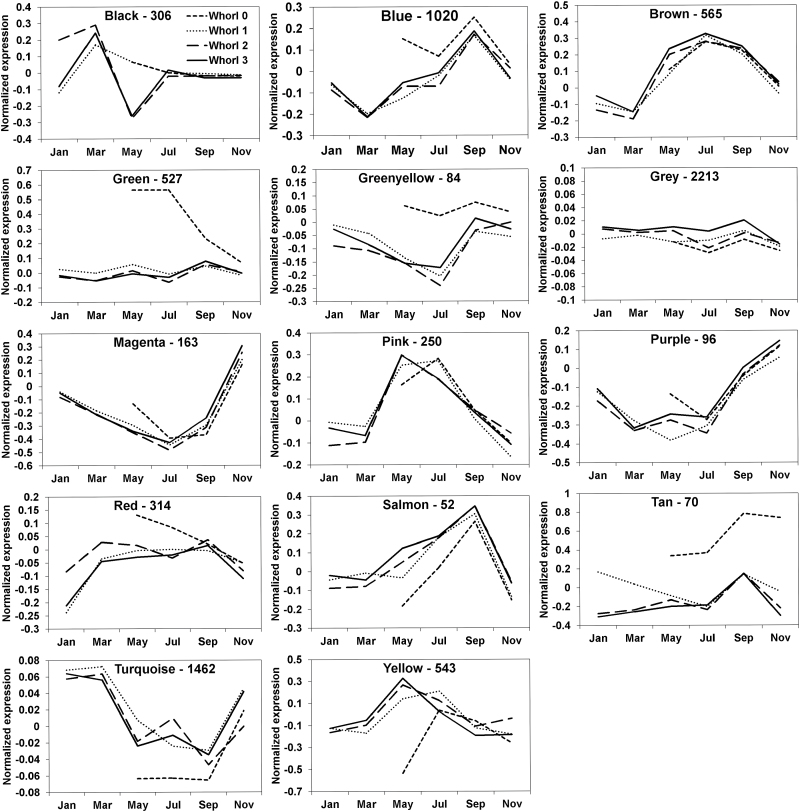
Mean expression profile of genes in each module. The gene expression profile for each whorl during the year is shown for each eigengene module. The number of genes included in each module is shown by its name. Whorls 0, 1, 2, and 3 are represented by dashed, dotted, broken, and continuous lines. Data are means of three values from the normalized microarray data.